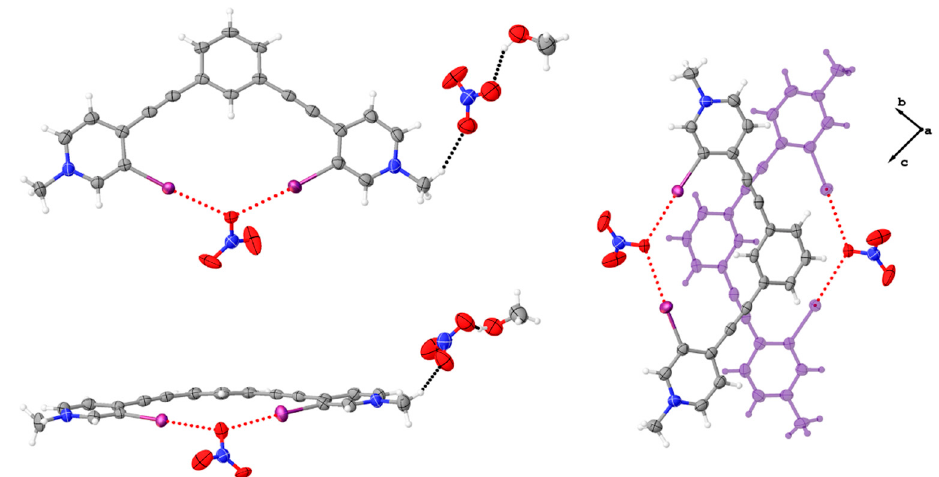
Figure 5. Asymmetric unit of 3•MeOH highlighting the bidentate conformation, the halogen bonds (red dotted lines) to the nitrate anion, and the hydrogen bonding (black dotted lines) to the nitrate anion outside the pocket ( upper and lower left ). The upper left image shows a top down view while the bottom left image is from the side, highlighting the convergent halogen bonds to a single oxygen atom. The image to the right highlights the centered antiparallel dimer as viewed down the crystallographic a axis. Thermal ellipsoids drawn at the 50% probability level and anion disorder omitted for clarity.